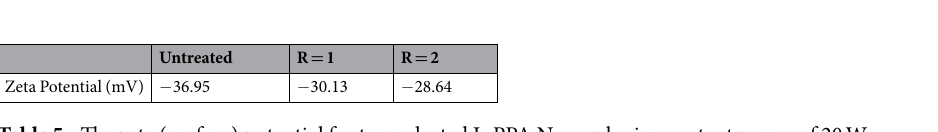
Figure 10. Topology after one and also eight days of immersion into different types of PBS and DI water.